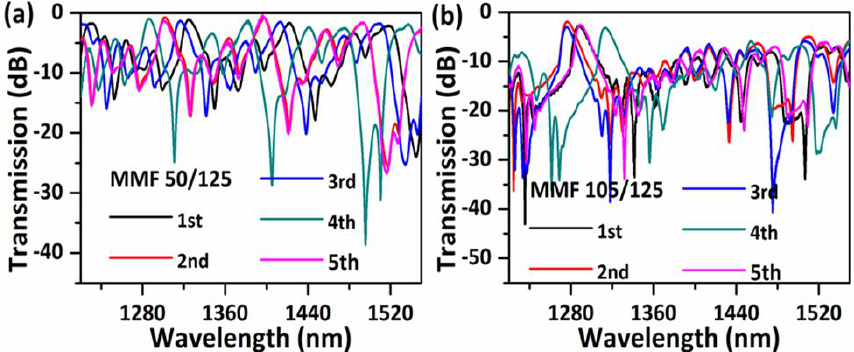
Figure 8. Measured transmission spectra of five sensor samples with an MMF length of ~39 mm for ( a ) MMF 50/125; and ( b ) 105/125.